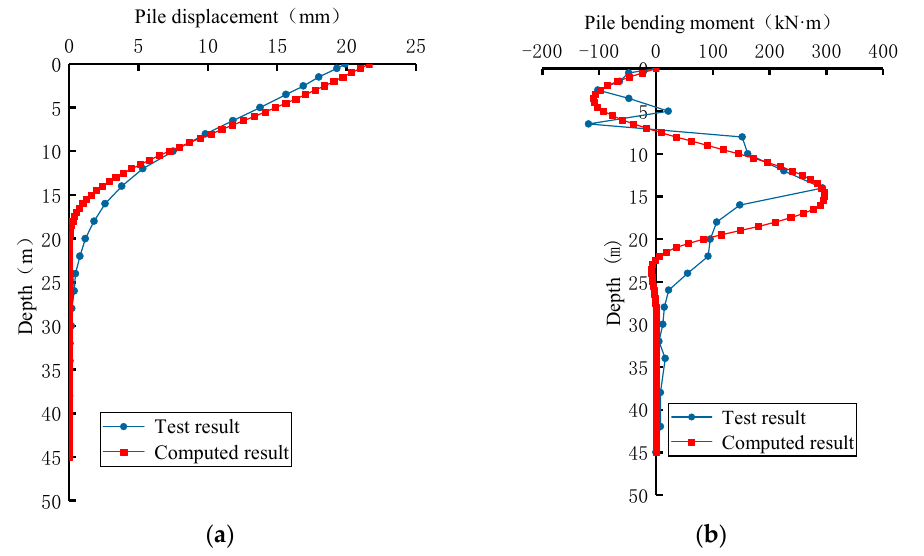
Figure 8. The calculated and measured values in working condition 2 ( e = 10 m). ( a ) Pile displacement; ( b ) pile-bending moment.